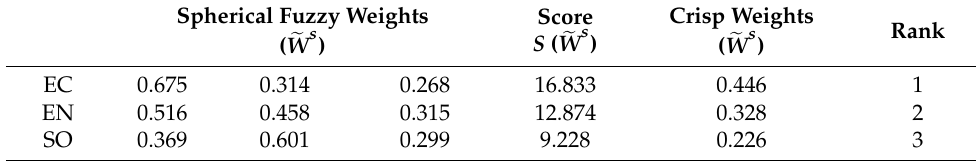
Table 12. Weights of main